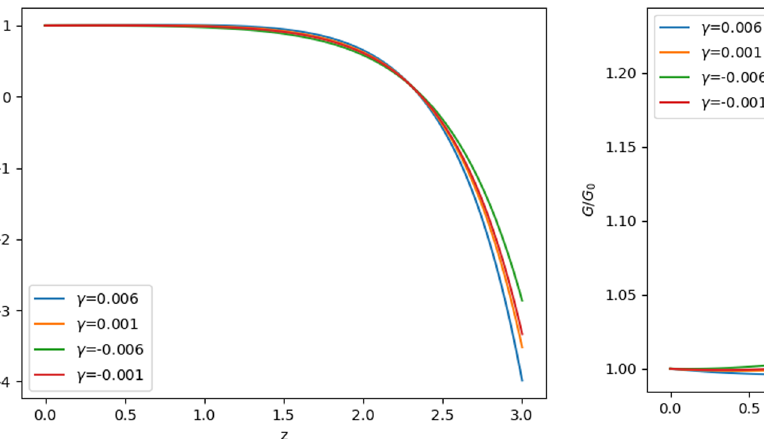
Figure 3: The variation G in redshift, as normalised by the value of G 0 today.